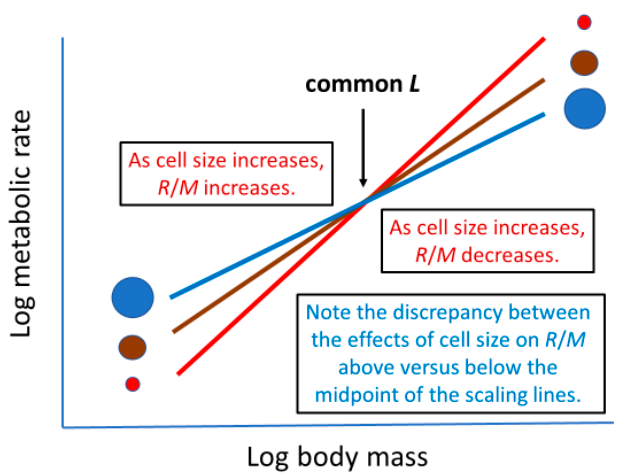
Figure 8. Schematic representation of how cell size (depicted by sizes of circles) may affect the metabolic scaling slope ( b ) when comparing scaling relationships with the same L (metabolic level or log mass-specific metabolic rate at the midpoint of the log body-mass range) and thus common midpoint (according to the mechanism posited by [36]). Note the discrepancy between the effects of cell size on R / M (mass-specific metabolic rate) above versus below the midpoint of the scaling lines.